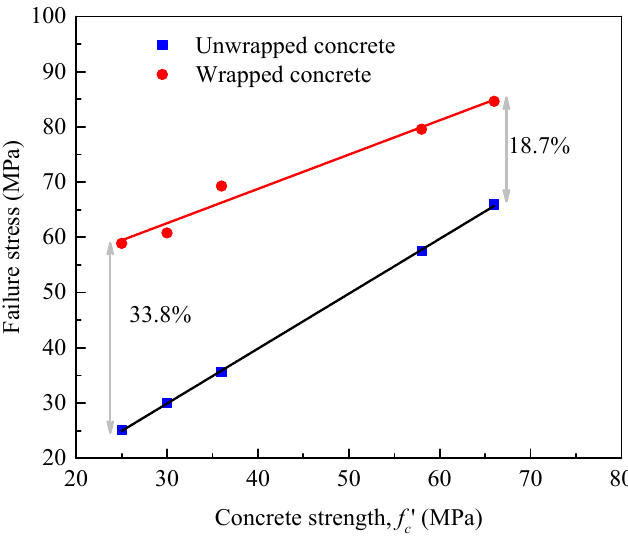
Figure 13. Normalized peak compressive axial load versus load eccentricity